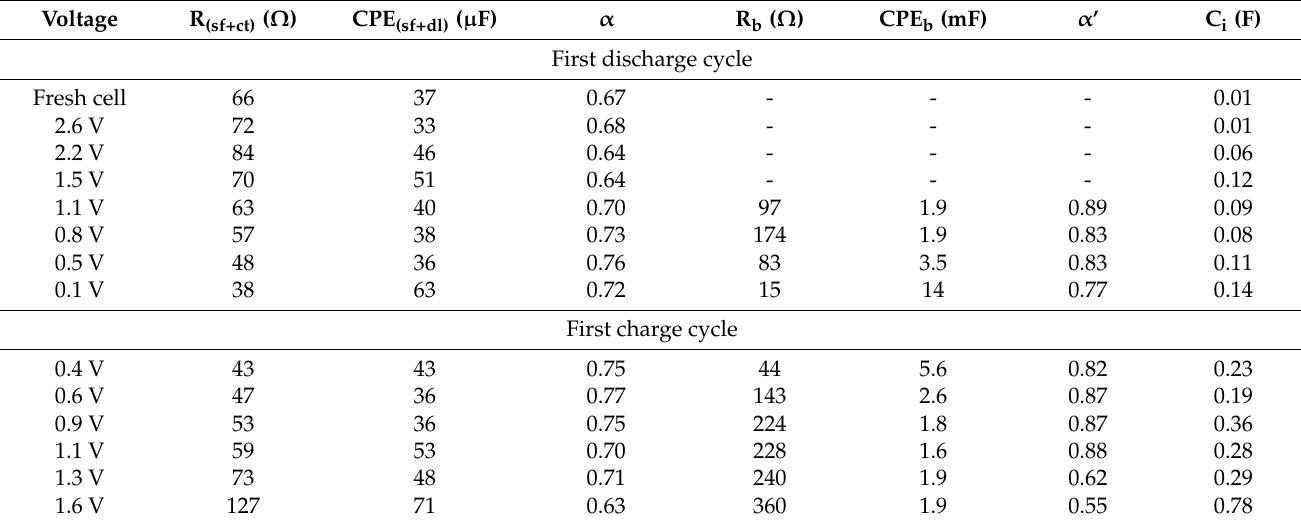
Table 2. EIS fitting results of G-NiFum at different voltages for the first cycle.